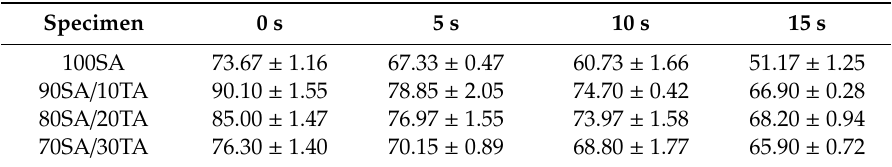
Table 1. Glycerin contact angle on the films surface.